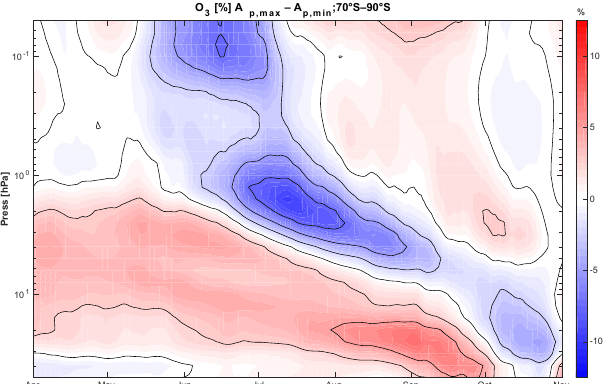
Figure 18. Ozone interannual variation due to geomagnetic forcing in 2005–2011 from the EMAC model run using the MIPAS-derived UBC for NO y . Shown are 27-day running means of the mean of the 3 years with highest mean of the 3 years, with lowest geomag- netic activity averaged over 70–90 ◦ S. EMAC results are in excel- lent agreement with O 3 observations using a three-satellite